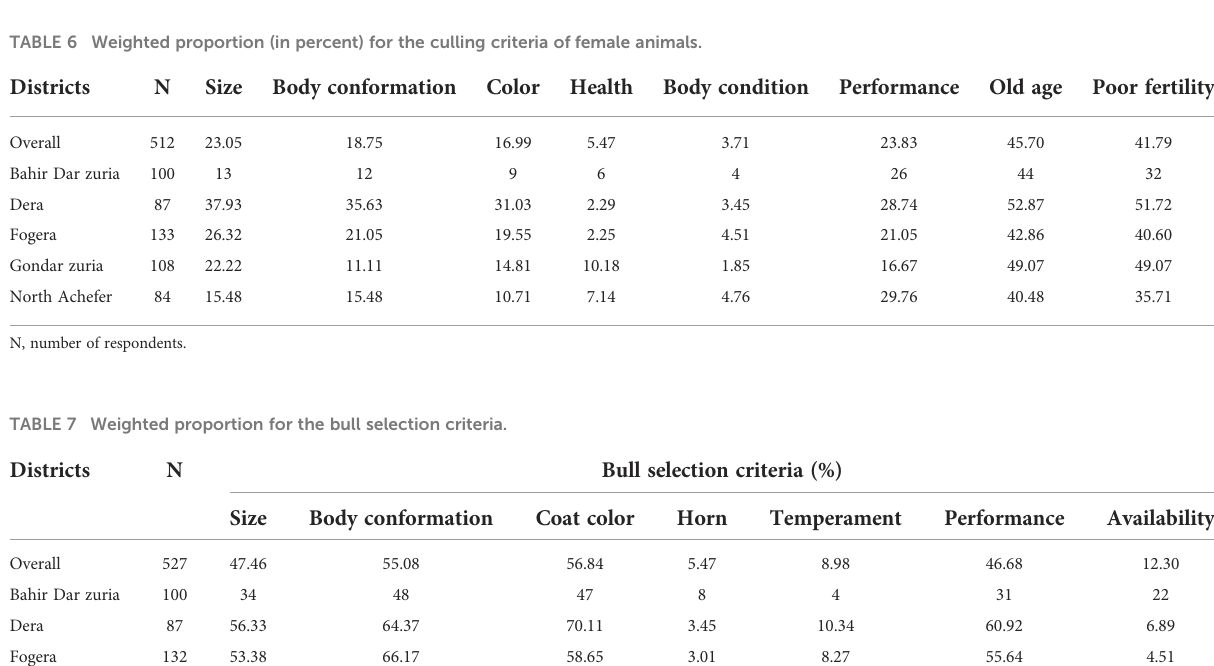
N, number of respondents.